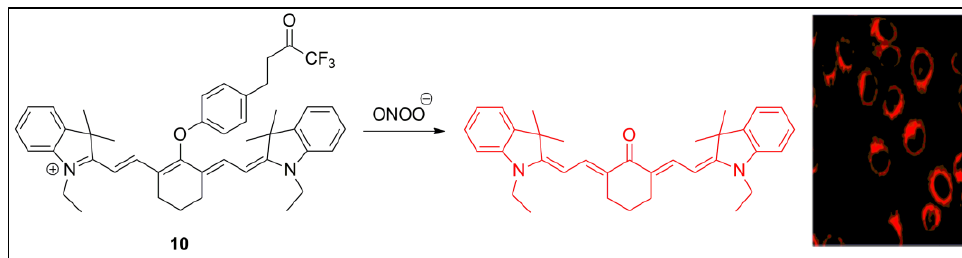
probe 10 (10 μ M) for 30 min under hypoxic conditions with 1% O 2 . Adapted with permission from probe 10 (10 µ M) for 30 min under hypoxic conditions with 1% O 2 . Adapted with permission [63]. Copyright (2022) Elsevier. from [63]. Copyright (2022) Elsevier.